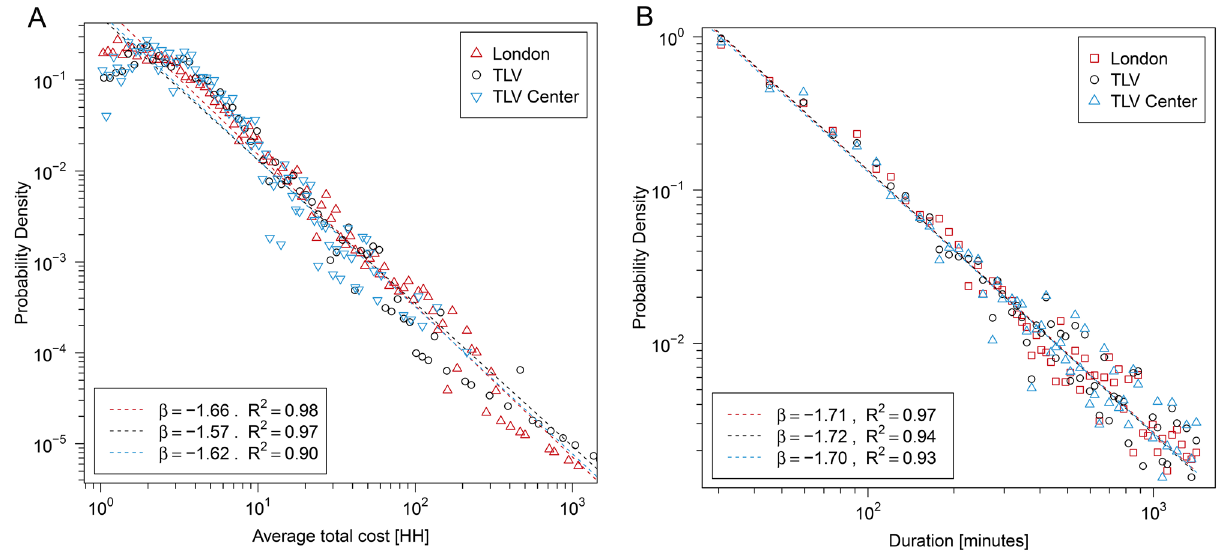
Figure 1. Analysis of the PDFs of the RJTs in London, Tel Aviv, and Tel Aviv Center (based on the data of all TotalCost RJT 5 days). ( A ) PDF of average cost, Ave.Cost RJT = N , where N represents the number of JTs in the SJT; ( B ) PDF of duration (in